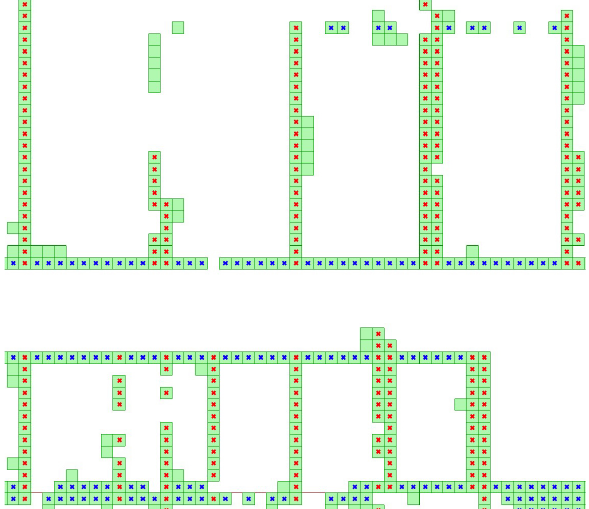
Figure 7 . Valid cells classified according to the orientation of the neighbouring follower and the detachment. The colour of the centre of the cells indicates the direction (blue > X, red > Y). Cells without a centre indicated to be